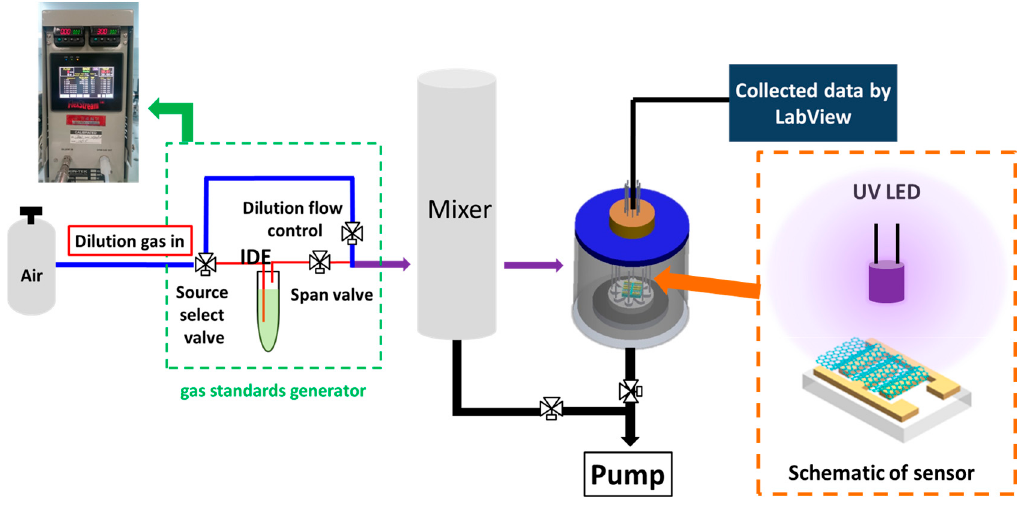
Figure 1 . Schematic of sensor measurement setup .